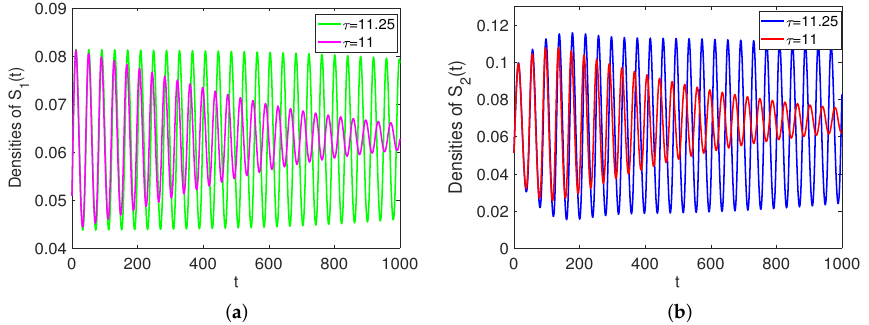
Figure 12. ( a ) The trajectories of S 1 ( t ) with τ = 11 and τ = 11.25. ( b ) The trajectories of S 2 ( t ) with τ = 11 and τ = 11.25.